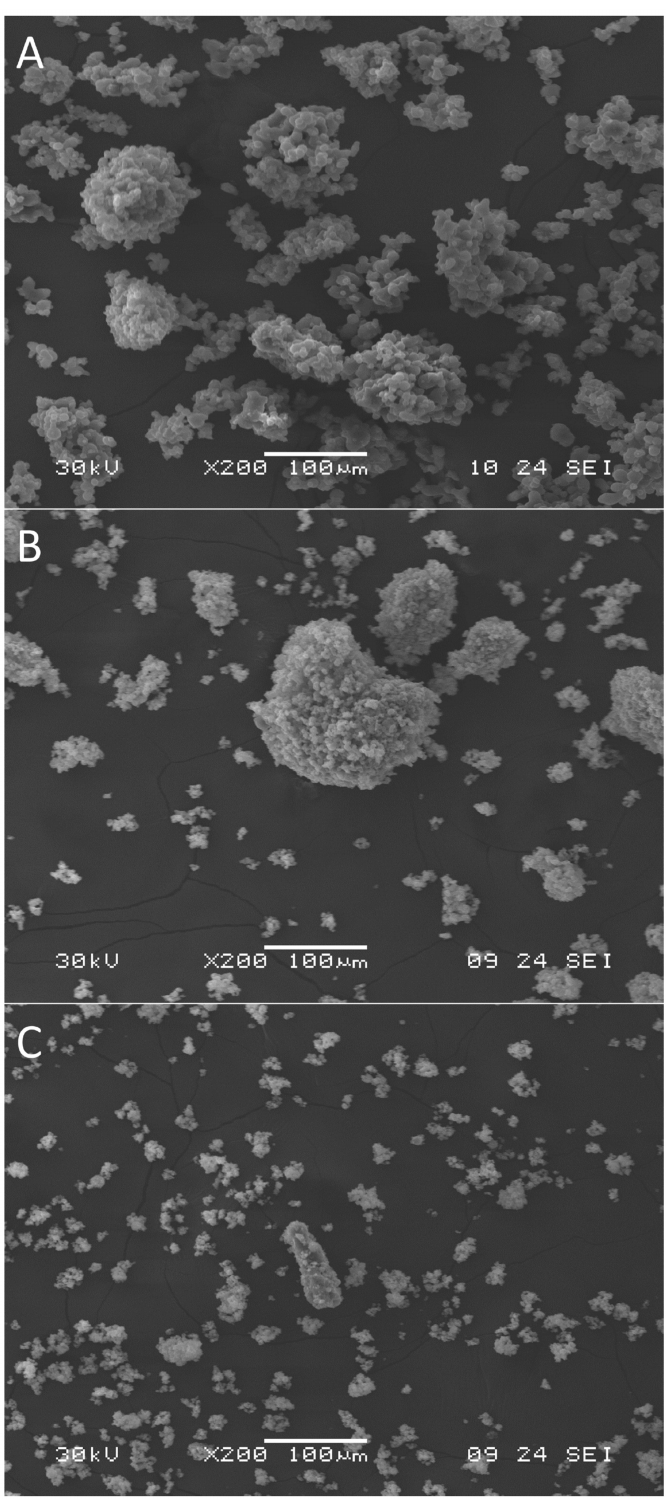
Figure 5. SEM images of the microstructure of spray-dried samples of autolysis supernatant ( A ) and iron–peptide complexes at protein concentrations of 1 g/L ( B ) and 17 g/L ( C